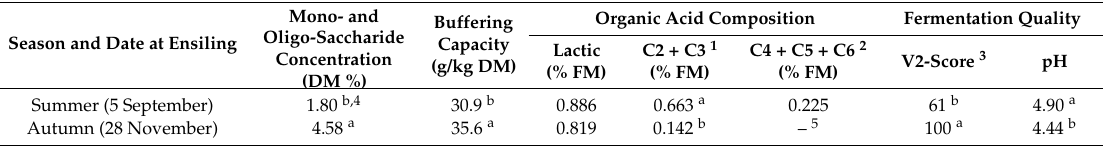
Table 5. Mono- and oligo-saccharide concentration and buffering capacity at ensiling, organic acids and fermentation quality in round-bale silages of dwarf Napiergrass ensiled in summer and autumn seasons (Experiment